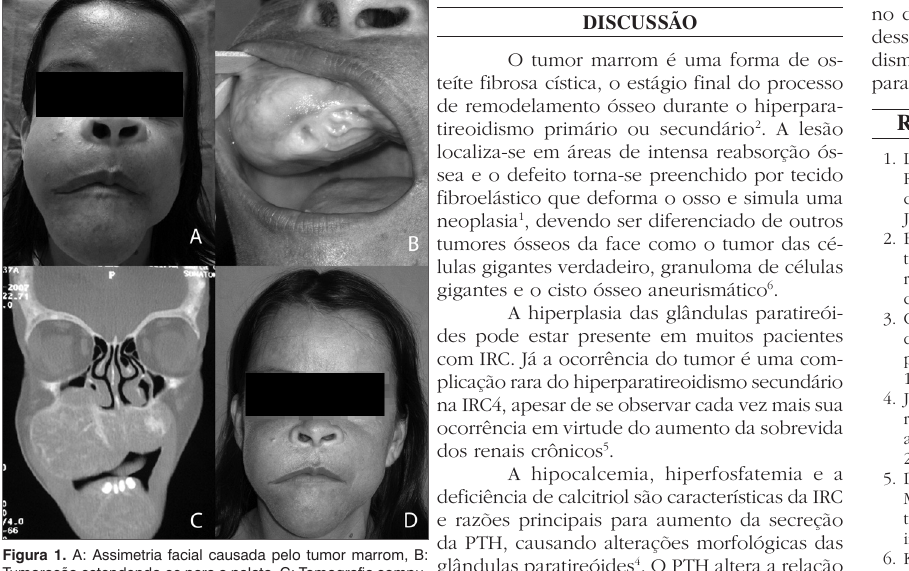
Figura 1. A: Assimetria facial causada pelo tumor marrom, B: Tumoração estendendo-se para o palato, C: Tomografia